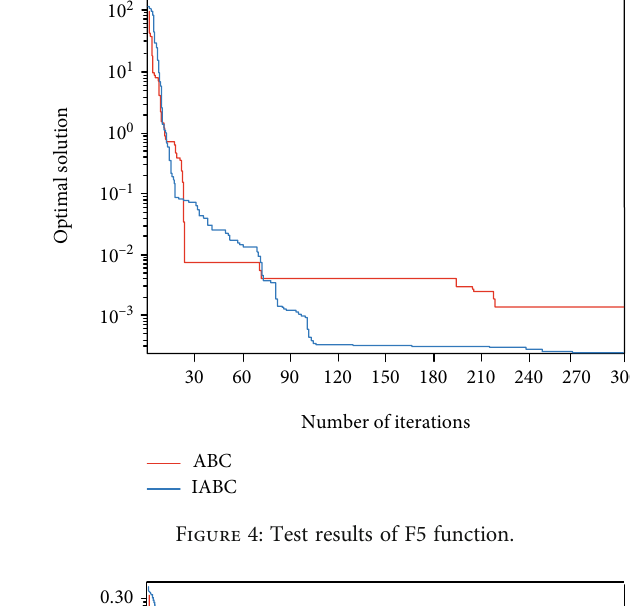
Figure 2: Test results of F1 function.